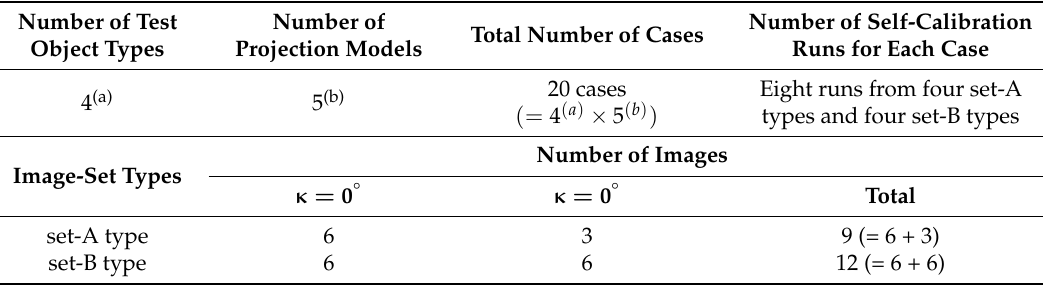
Table 4. Image setting configuration for self-calibration